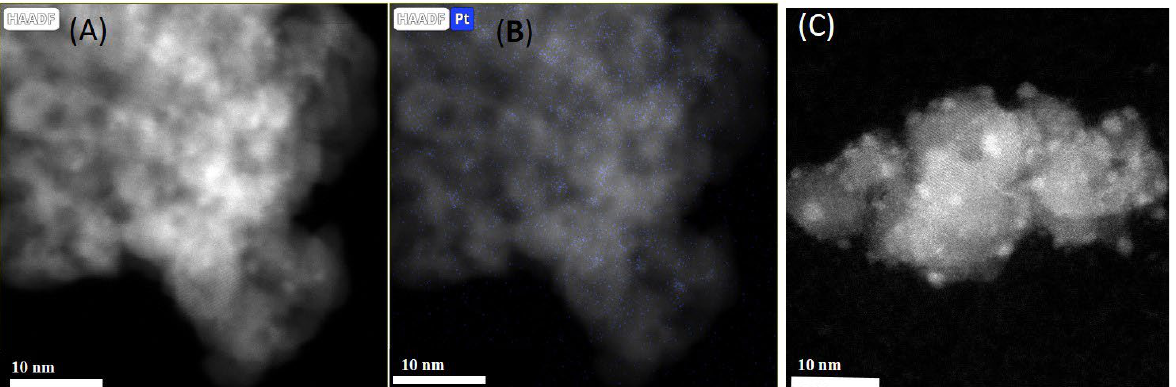
Figure 3. ( A ) HAADF-STEM images of the 1.3 wt.% Pt/CeO 2 and ( B ) STEM-EDX map analysis on the same area indicating the Pt distribution. ( C ) Pt-particles on 1.3 wt.% Pt/CeO 2 after reaction.